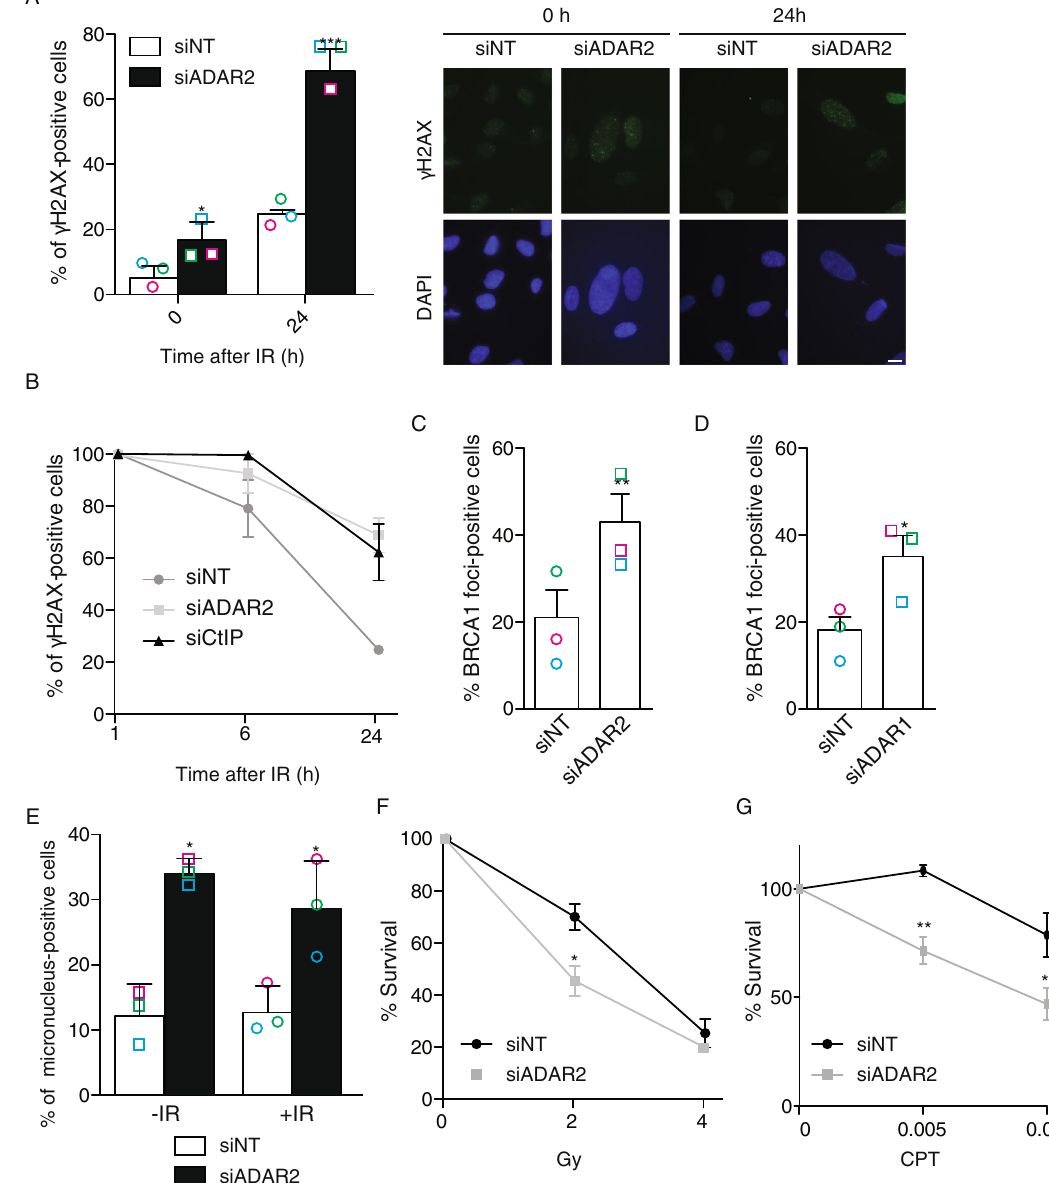
Fig. 2 ADAR2 depletion causes genetic instability and DNA repair defects. A Percentage of cells positive for γ H2AX foci upon spontaneous accumulation (0 h) or 24 h post irradiation with 10 Gy in U2OS cells transfected either a siRNA against ADAR2 or with control siNT. Quanti fi cation is shown on the left. A representative image is shown on the right. Scale bars represent 10 µ m. B Repair kinetics is shown as the disappearance of γ H2AX foci 1, 6, and 24 h post irradiation with 10 Gy in U2OS cells transfected either a siRNA against ADAR2, CtIP or with control siNT. C Percentage of spontaneous BRCA1 foci-positive cells in cells transfected with either a siRNA against ADAR2 or with control siNT. The average and SD of three independent experiments is shown. D Same as C but in cells depleted for ADAR1. E Percentage of cells positive for micronucleus without exposure to DNA damage (-IR) or 24 h post irradiation with 10 Gy ( + IR) in U2OS cells transfected either with a siRNA against ADAR2 or with control siNT. Other details as in ( A ). F Clonogenic assays of U2OS cells depleted with a siRNA against ADAR2 or with control siNT after treatment with different doses of IR. Other details as in ( A ). G Same as F but cells treated with camptothecin (CPT; μ M; right). In all panels, the average and SD of three independent experiments are shown and statistical signi fi cance was determined with a two-tailed paired Student ’ s t -test. Each individual replica is marked with a colored symbol. One, two, or three asterisks represent p < 0.05, p < 0.01, or p < 0.001, respectively. Actual p -values can be found in the Source data fi le. Only biological relevant comparisons are